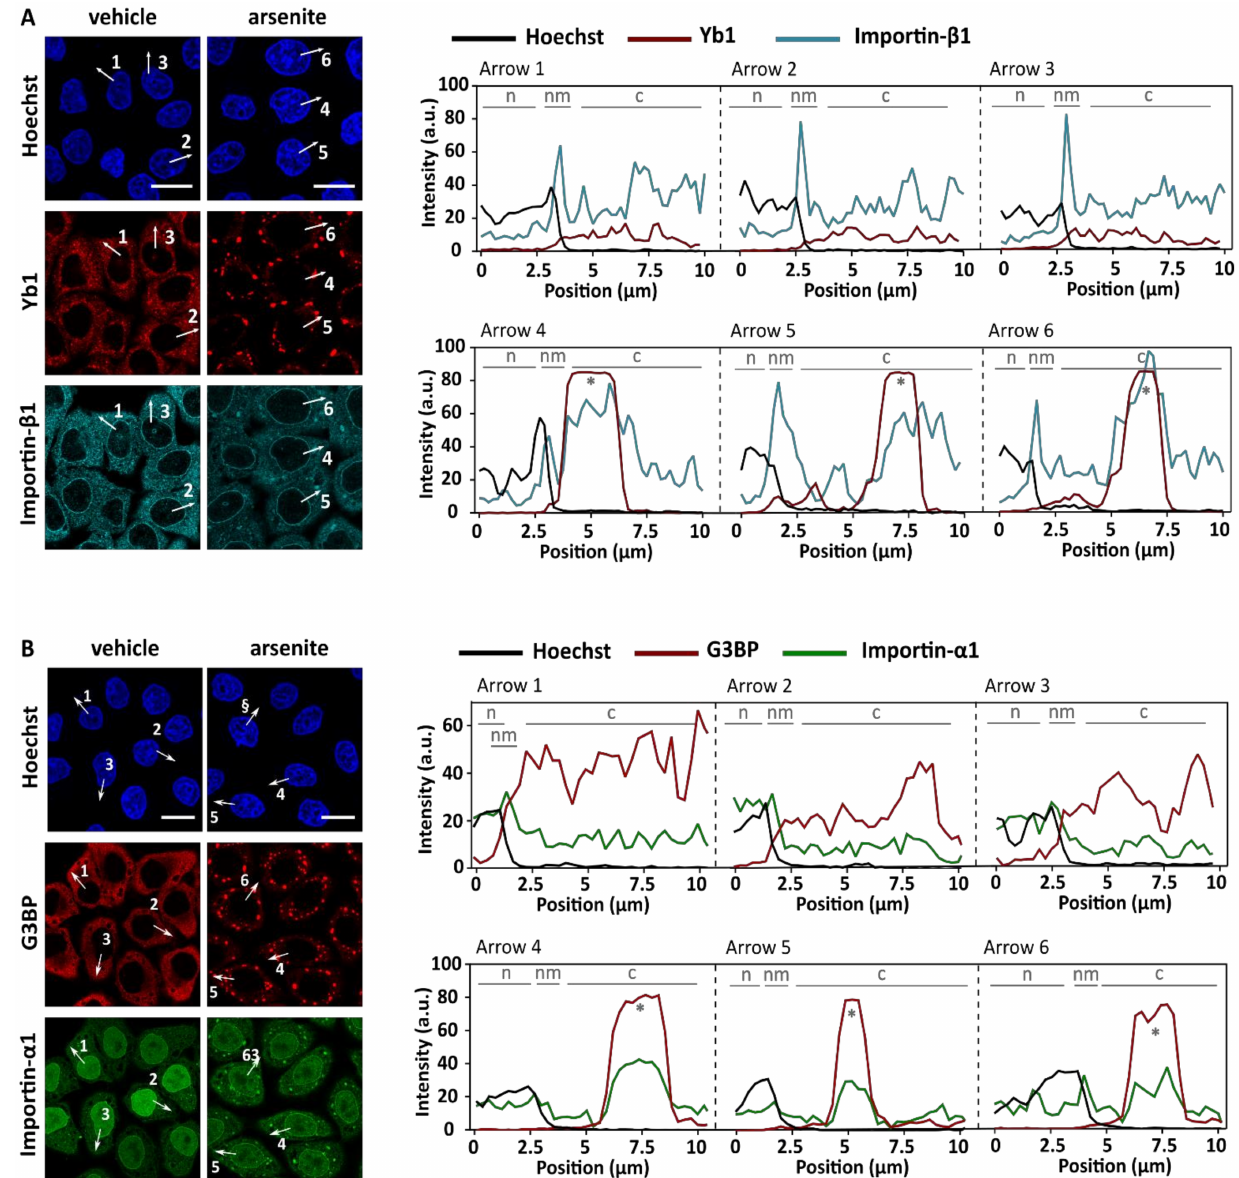
Figure 1. Importin- β 1 and importin- α 1 localize at arsenite-induced stress granules. ( A ). HeLa Kyoto cells were treated with 500 µ M sodium arsenite (NaAsO 2 ) for 60 min before fixation with 4% PFA. Cells were stained with an anti-Y-box binding protein (yb1) antibody (=stress granule marker) and an anti-importin- β 1 antibody. Hoechst was used to visualize the nucleus. Arsenite treatment resulted in the formation of stress granules in which importin- β 1 localizes, which is confirmed by the intensity plots shown on the right. N = nucleus; nm = nuclear membrane; c = cytoplasm; * = stress granule. Scale bar = 20 µ m. ( B ). HeLa Kyoto cells endogenously expressing importin- α 1-mNeonGreen were treated for 60 min with 500 µ M arsenite and stained with an anti-G3BP antibody (stress granule marker) after fixation. Importin- α 1 localized at stress granules, which is confirmed by the intensity plots shown on the right. n = nucleus; nm = nuclear membrane; c = cytoplasm; * = stress granule. Scale bar = 20 µ